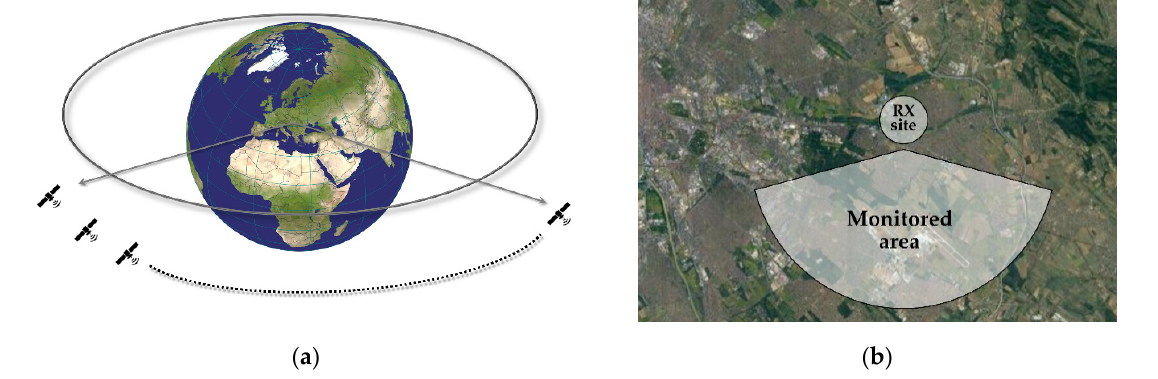
Figure 1. ( a ) Satellite receiving range: about 140°; ( b ) The simulation area: city of Budapest with the ground receiver station and the public airport as the monitored area.